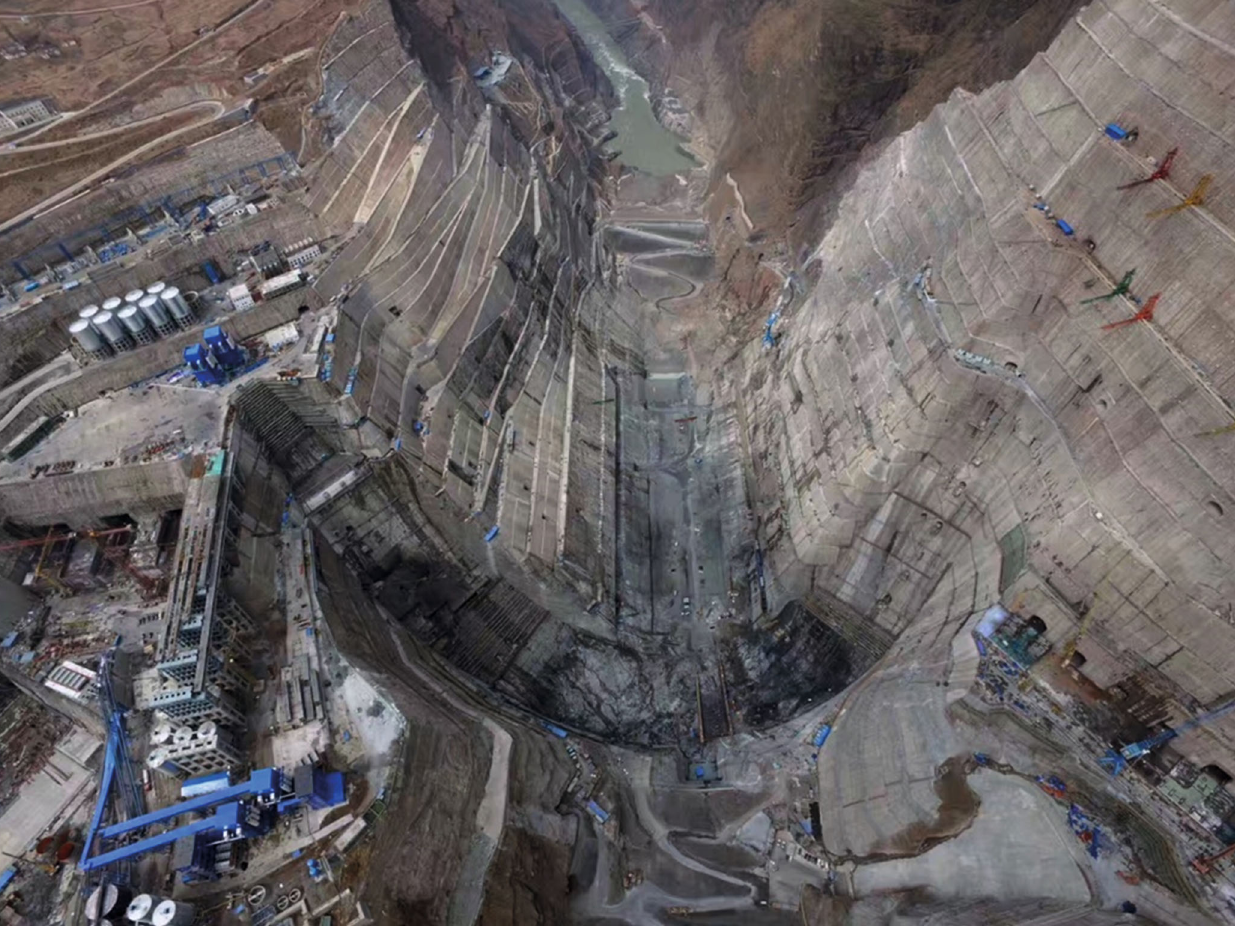
Figure 9: The fi nal excavation of the Baihetan dam